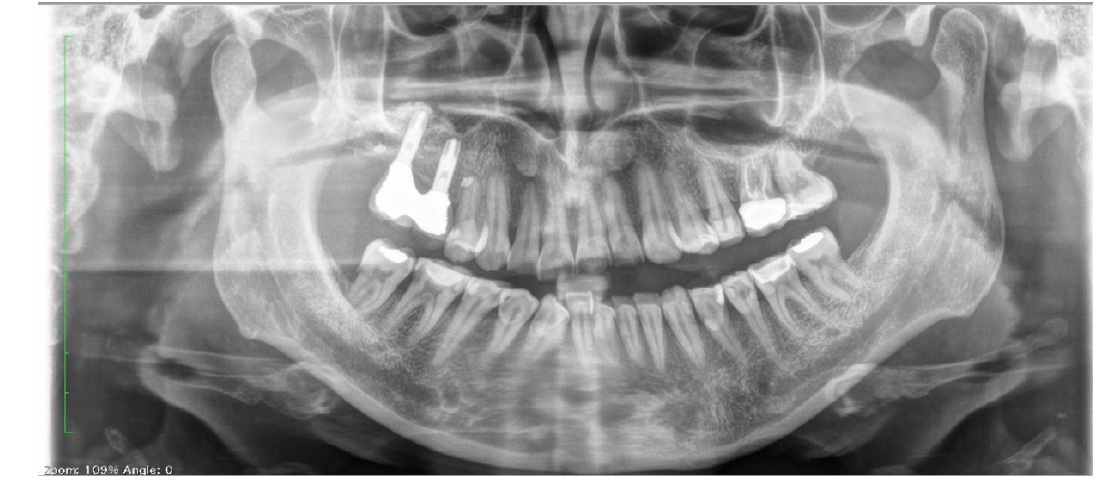
Figure 4. Pretreatment panoramic radiograph.